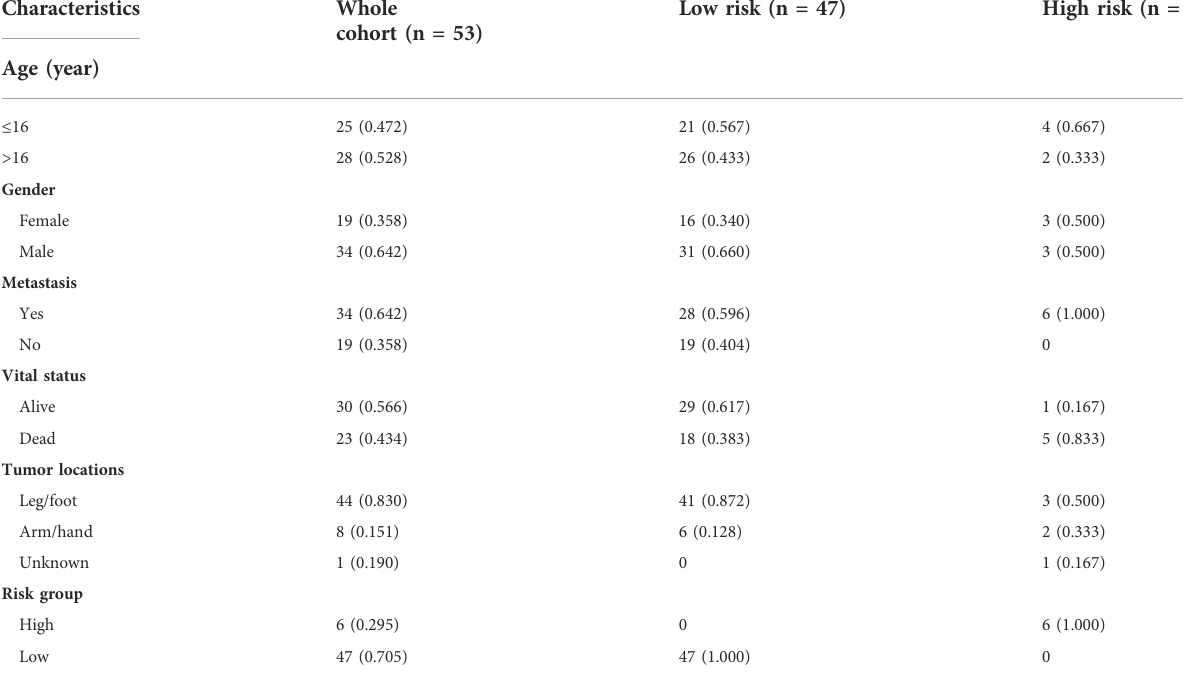
TABLE 5 The clinical information of osteosarcoma patients in the veri fi cation cohort from GSE21257.